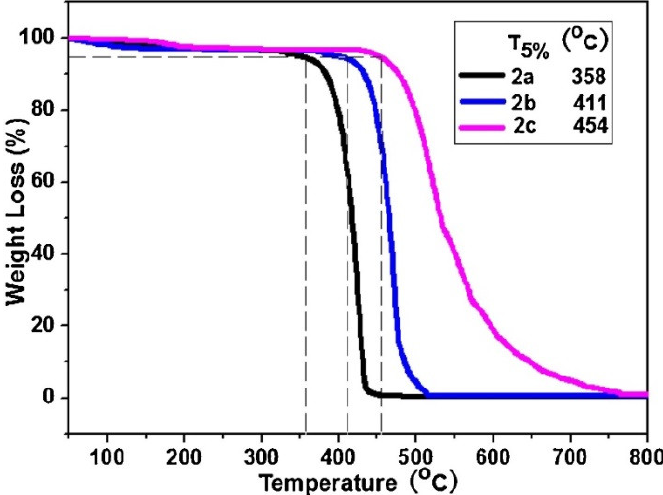
Figure 3. Thermogravimetric analysis of polymers, 2a–2c, collected under a N 2 atmosphere. Repro- duced with the permission of Reference [16]. Copyright 2017 Elsevier.